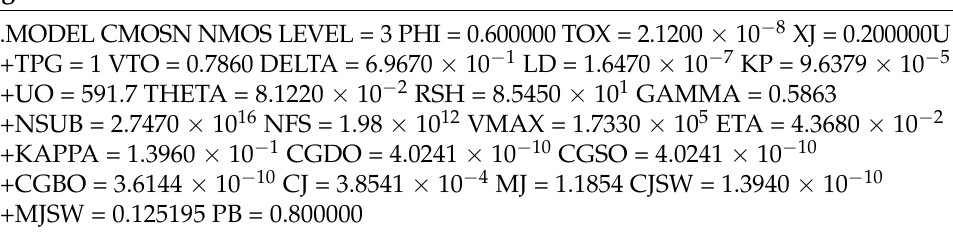
Algorithm 4 Model Parameters of CMOS VCO